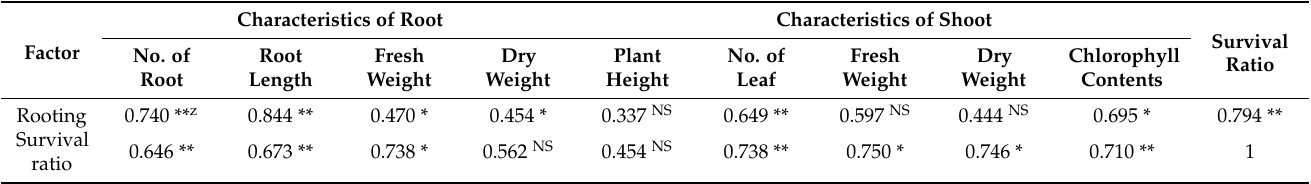
Table 1. Correlation between the root and shoot characteristics and rooting and survival ratio of Rhododendron micranthum